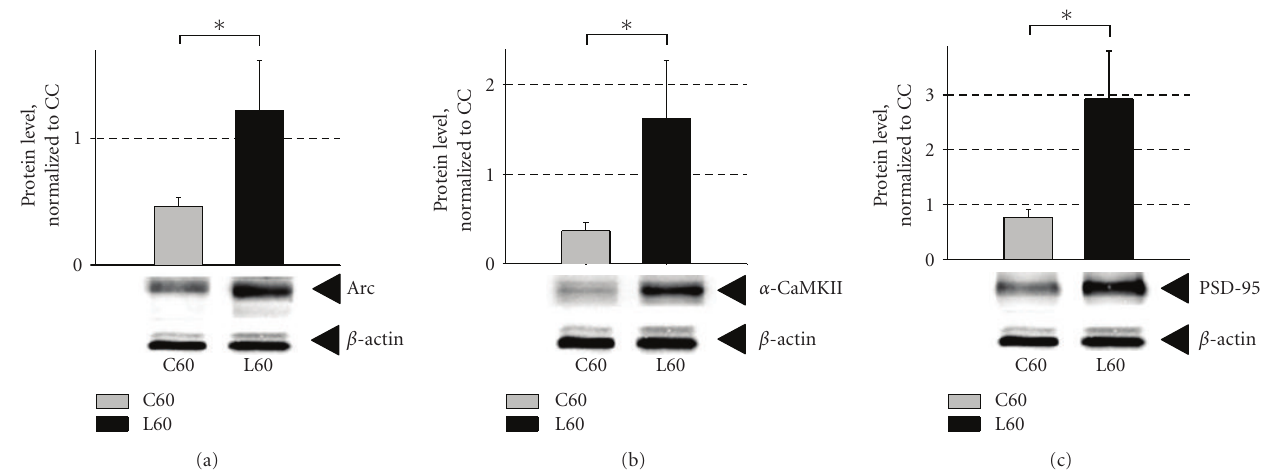
Figure 5: Object recognition training induces an increase in the expression of Arc, α -CaMKII, and PSD-95 proteins in the dentate gyrus. Representative blots and comparison of normalized protein levels of (a) Arc, (b) α -CaMKII, and (c) PSD-95 proteins are presented for the C60 and L60 groups (relative to CC). Data are presented as mean ± SEM ( n = 7 for all groups). Protein levels were normalized to β -actin. Asterisks indicate P ≤ .